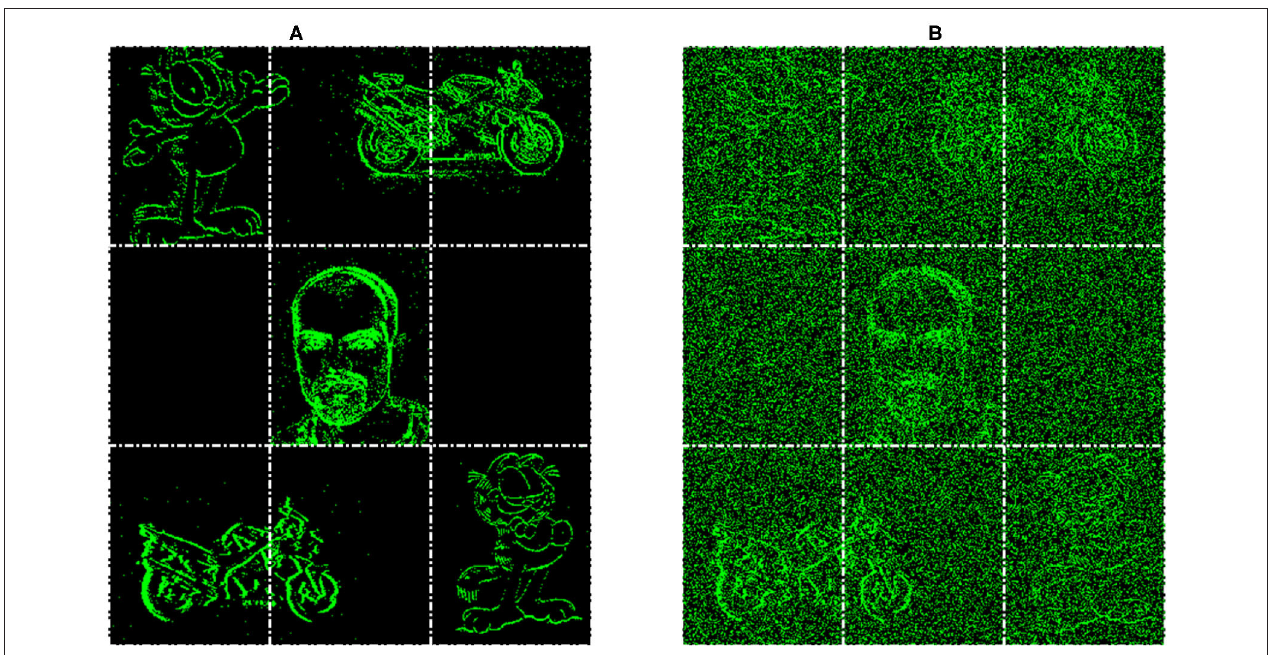
FIGURE 8 | Example of input for the Multi-Stream Input without noise (A) and with noise (B) , both with extra gridlines indicating the 3 × 3 grid which determines the initial location of the